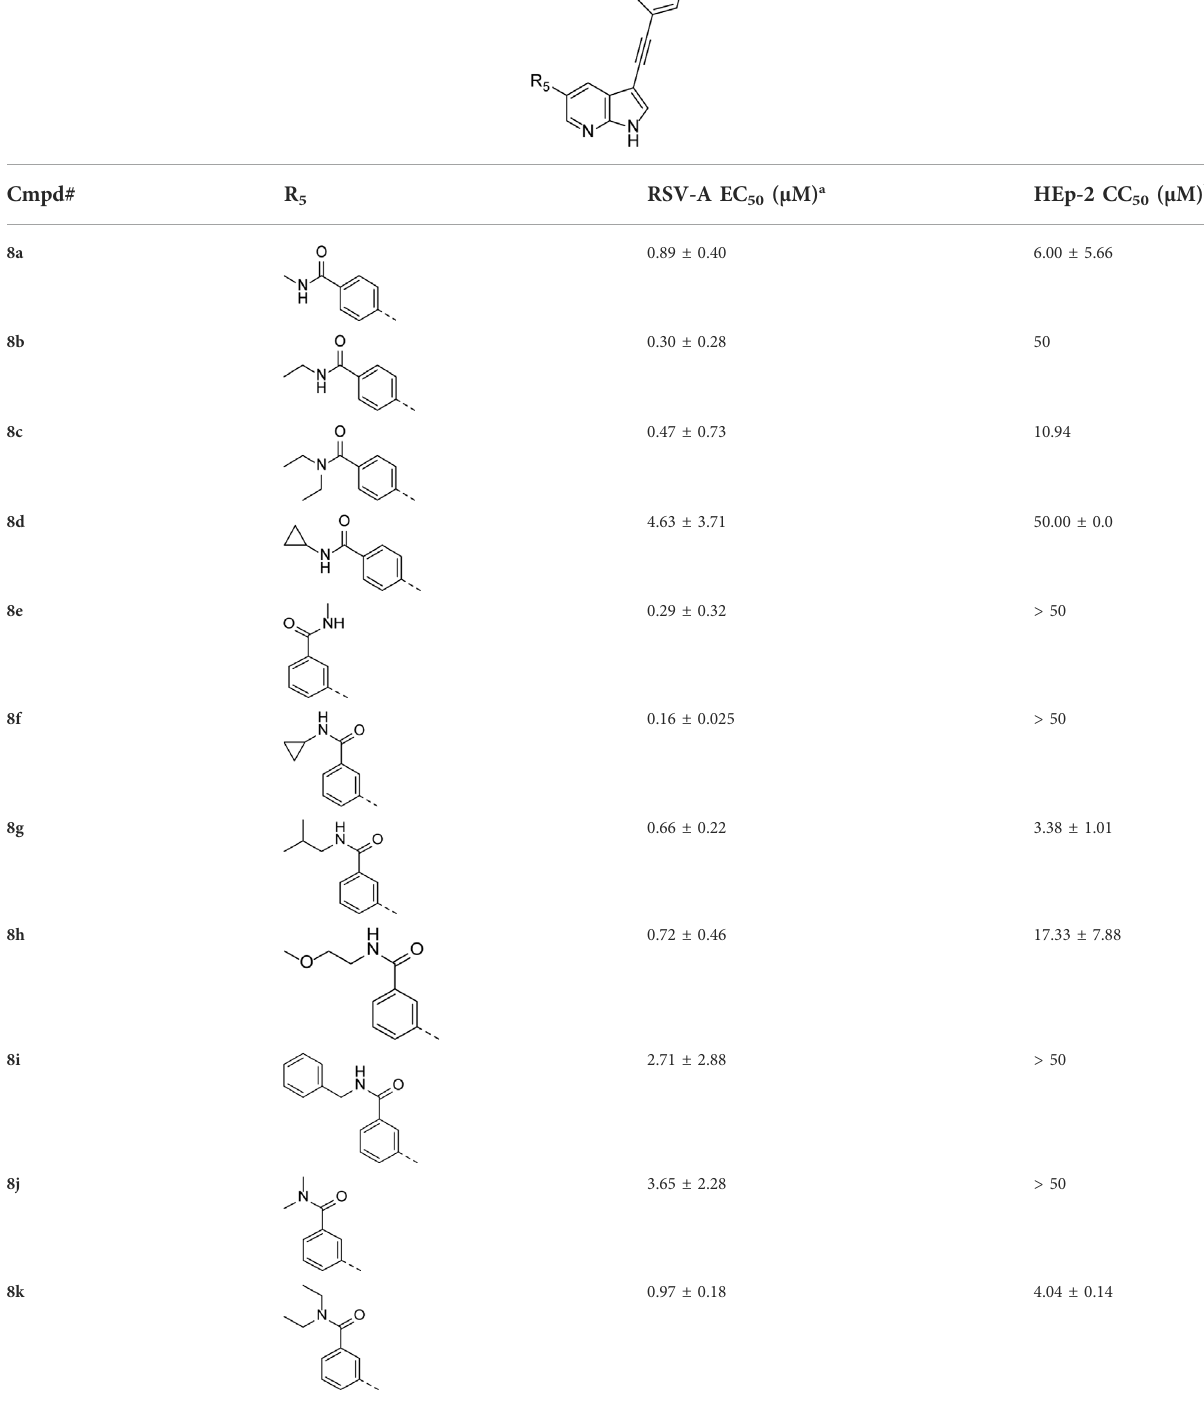
TABLE 5 Anti-RSV activity and cytotoxicity of 5-aryl-3-(3-pyridinyl)pyrrolo[2,3- b